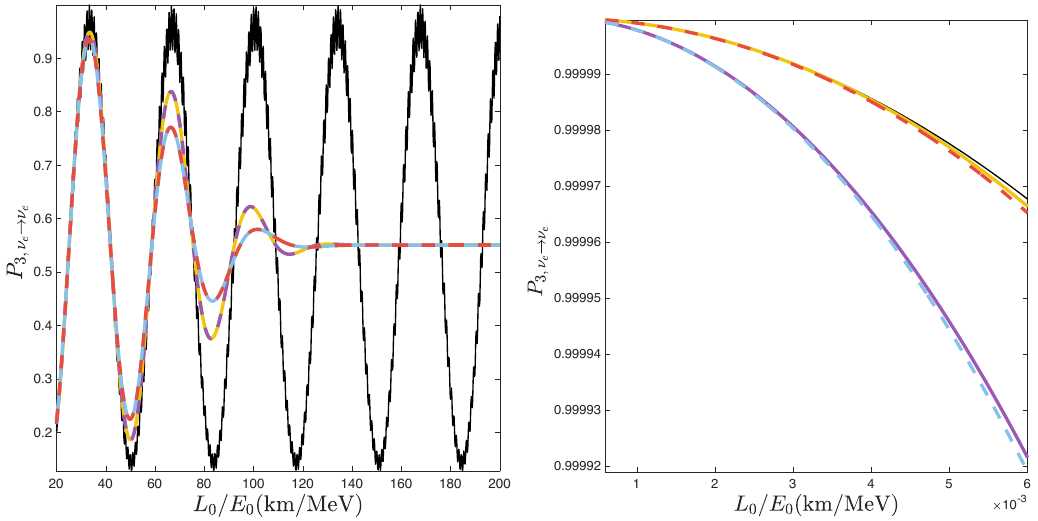
Figure 7 . FTP from electron neutrino to electron neutrino as a function of L 0 /E 0 on the measurement layer for near (right) and far (left) detector. The lines are labels in the same way as figure 6. We can identify more sensitivity to σ more pronounced at far